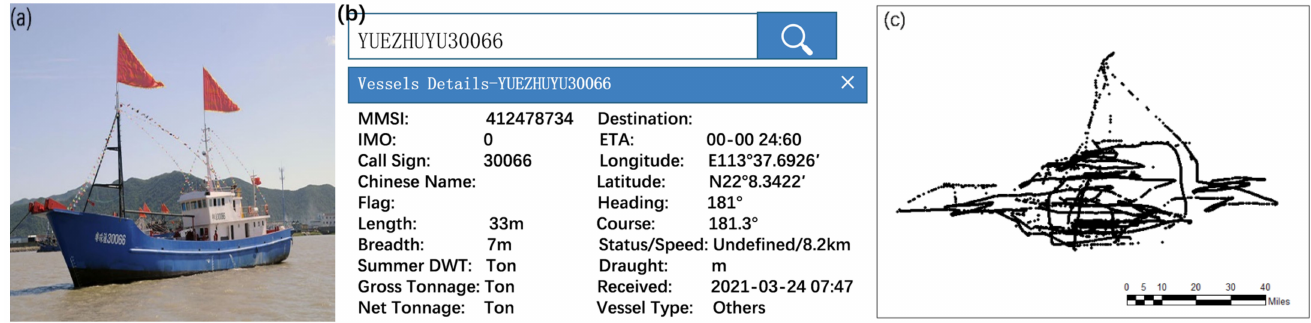
Figure 3. Collection process for the Automatic Identification System sample dataset. ( a ) Details of a trawler named YUEZHUYU30066 were obtained from the website of Ningbo Dajiang Shipbuilding Co. Ltd (http://www.nbdjcy.com/ content/?828.html (accessed on 5 May 2021)). ( b ) The MMSI number of the trawler was identified through the fishing vessel query website of China Ports Net. ( c ) The ship’s activity track in April 2018 was derived from the AIS database based on the MSSI. It should be noticed that the trajectories of all three types are shown in the Figure